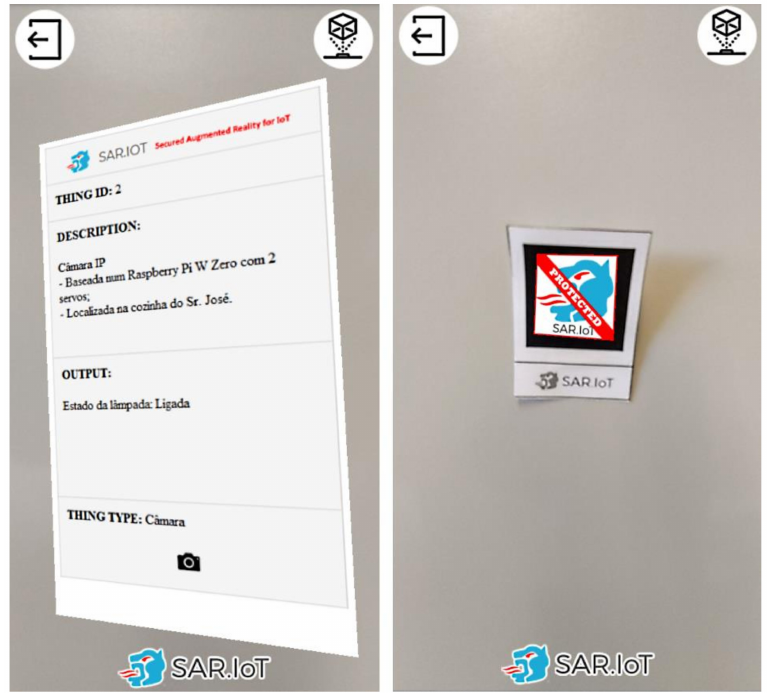
Figure 12. AR markers with ( left ) and without ( right ) access